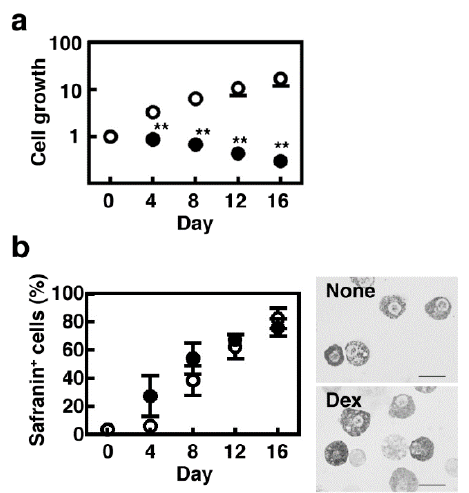
Figure 1. Bone marrow-derived cultured mast cells (BMMCs) were co-cultured with Swiss 3T3 fibroblasts in the presence (closed circles) or absence (open circles) of 1 µM dexamethasone for 16 days as described in Materials and Methods. ( a ) The numbers of the cultured mast cells were counted on day-0, 4, 8, 12, and 16. Values are presented as the means ± SEMs (n = 4). The values ** p < 0.01 are regarded as significant. ( b ) The ratios of the Safranin-positive cells were determined. Values are presented as the means ± SEMs (n = 4).